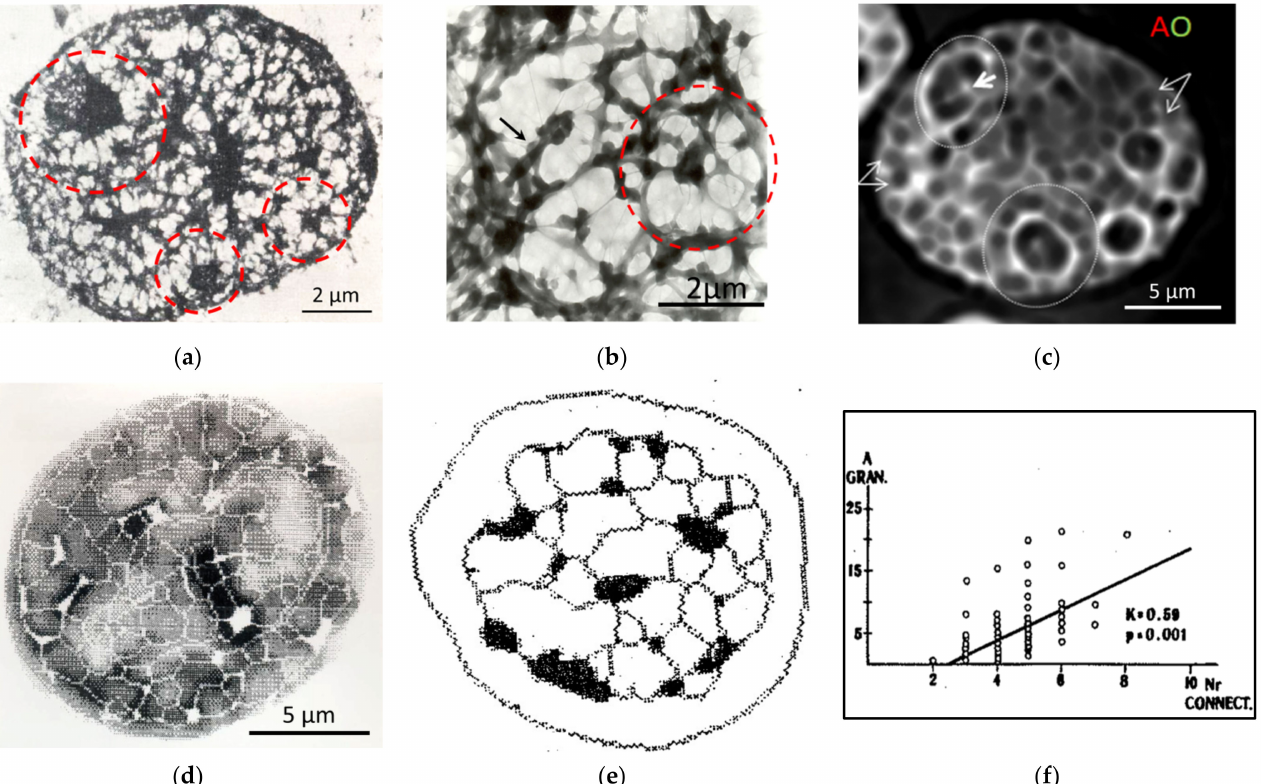
Figure 1. Visualization of the heterochromatin network in interphase cells: ( a,b ) Electron microscopic images of isolated rat thymocyte nuclei treated with 0.1% heparin/HBSS on supports; ( a ) 1 min; ( b ) 25 min (the nucleus fragment) by the method from [55]. PF fixation, uranyl acetate contrasting, tungsten oxide shadowing. ( c ) Human MCF7 cell, AO-DNA (after RNAse) fluorescent staining, deconvolution. ( a – c ) Large rosettes around nucleoli are encircled, heterochromatin clumps and “foots” inside them are arrowed, double alveoli are marked by double arrows. ( d ) Tissue imprint of chicken embryonic chondrocyte stained stoichiometrically for DNA; the method of image processing is described in [56]. ( e ) Mathematically skeletonized network of a DNA-stained chicken mesenchymal cell with overlaid dense chromocenters. ( f ) The relationship between the area of the dense chromocenters and the number of their network branches determined on chicken image-processed nuclei. Figure 1a,b republished from [52]. Figure 1d–f republished from